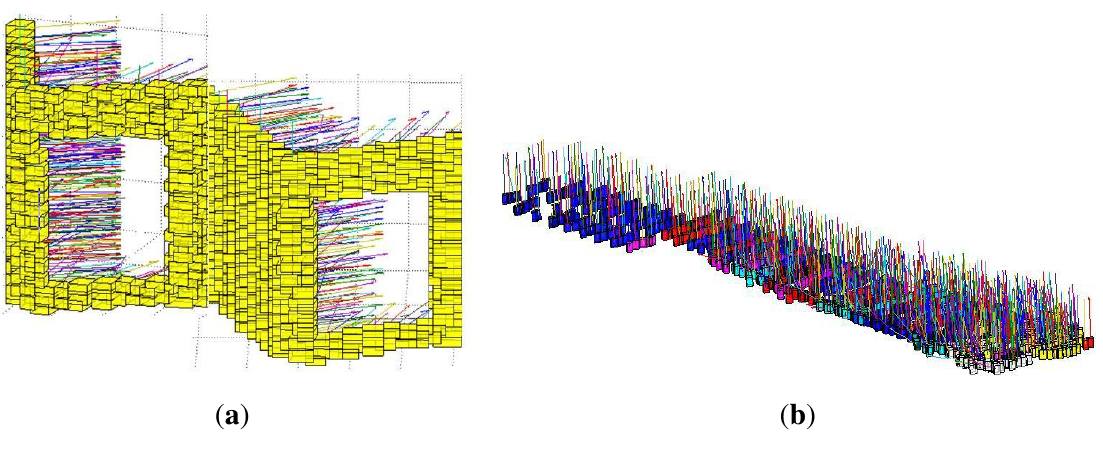
Figure 4. (a) Normals of building—shows surface normals of building s -voxels that are parallel to the ground plane. In (b) Normals of road—it can be clearly seen that the surface normals of road surface s -voxels are perpendicular to the ground plane.